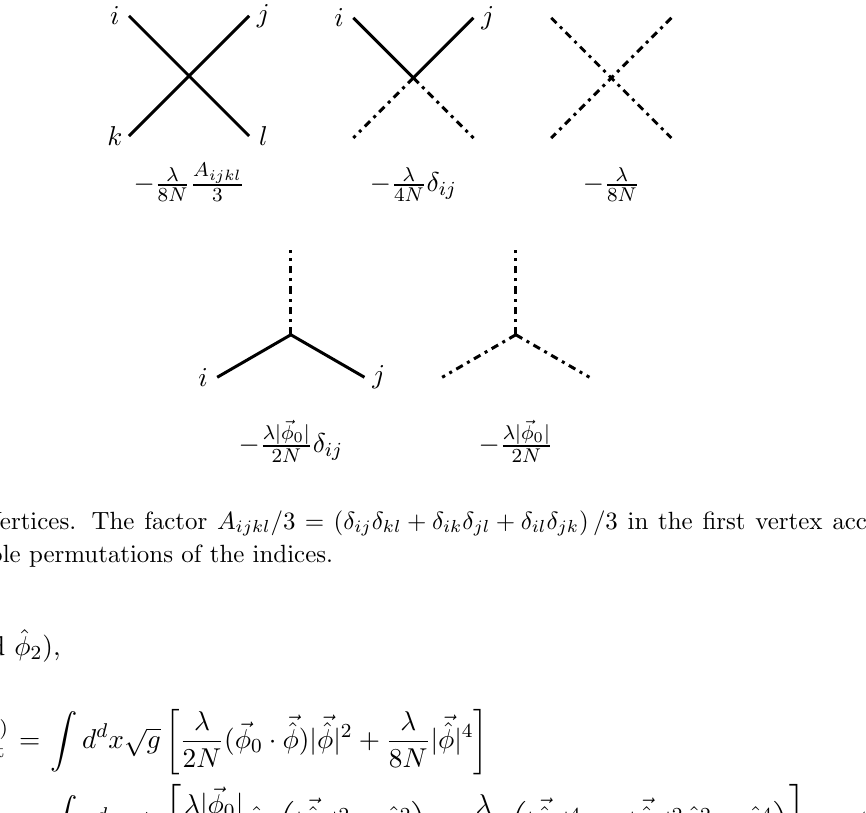
Figure 1 . Massive inhomogeneous propagators ˆ G